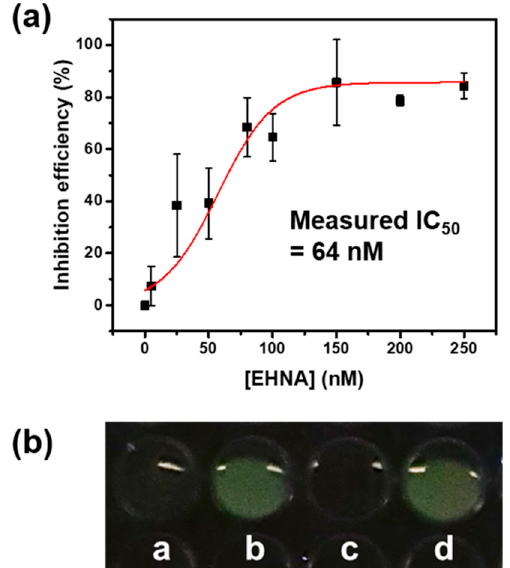
Figure 5. ( a ) Plot of inhibition efficiency of EHNA versus various inhibitor concentrations, condition: adenosine 50 μ M, Tb 3+ 1 mM, ADA 0.2 U/mL in buffer condition (pH 8; HEPES, 20 mM), λ ex = 260 nm. ( b ) Photograph taken under a hand-held UV lamp (254 nm) after 20 min, a: adenosine (1 mM) + Tb 3+ (20 mM) b: a + ADA (0.2 U/mL), c: b + EHNA (10 μ M), d: b + theobromine (10 μ M).